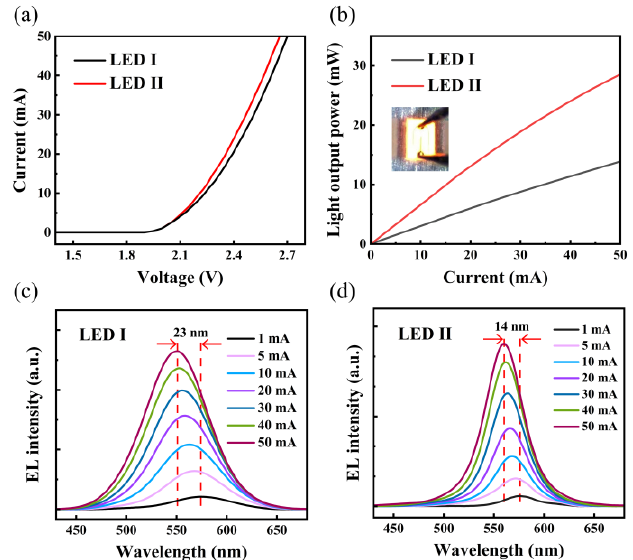
Figure 3. ( a ) I-V characteristics for sample I and sample II. ( b ) L-I characteristic for sample I and sample II. Normalized EL spectra for ( c ) LED I and ( d ) LED II at room temperature with increasing forward currents, respectively.